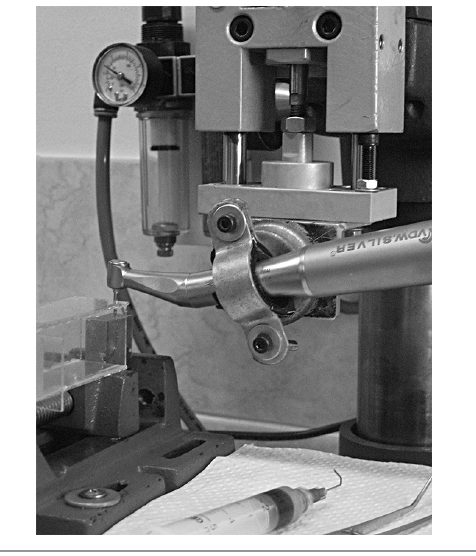
Figure 2. The Cyclic fracture test